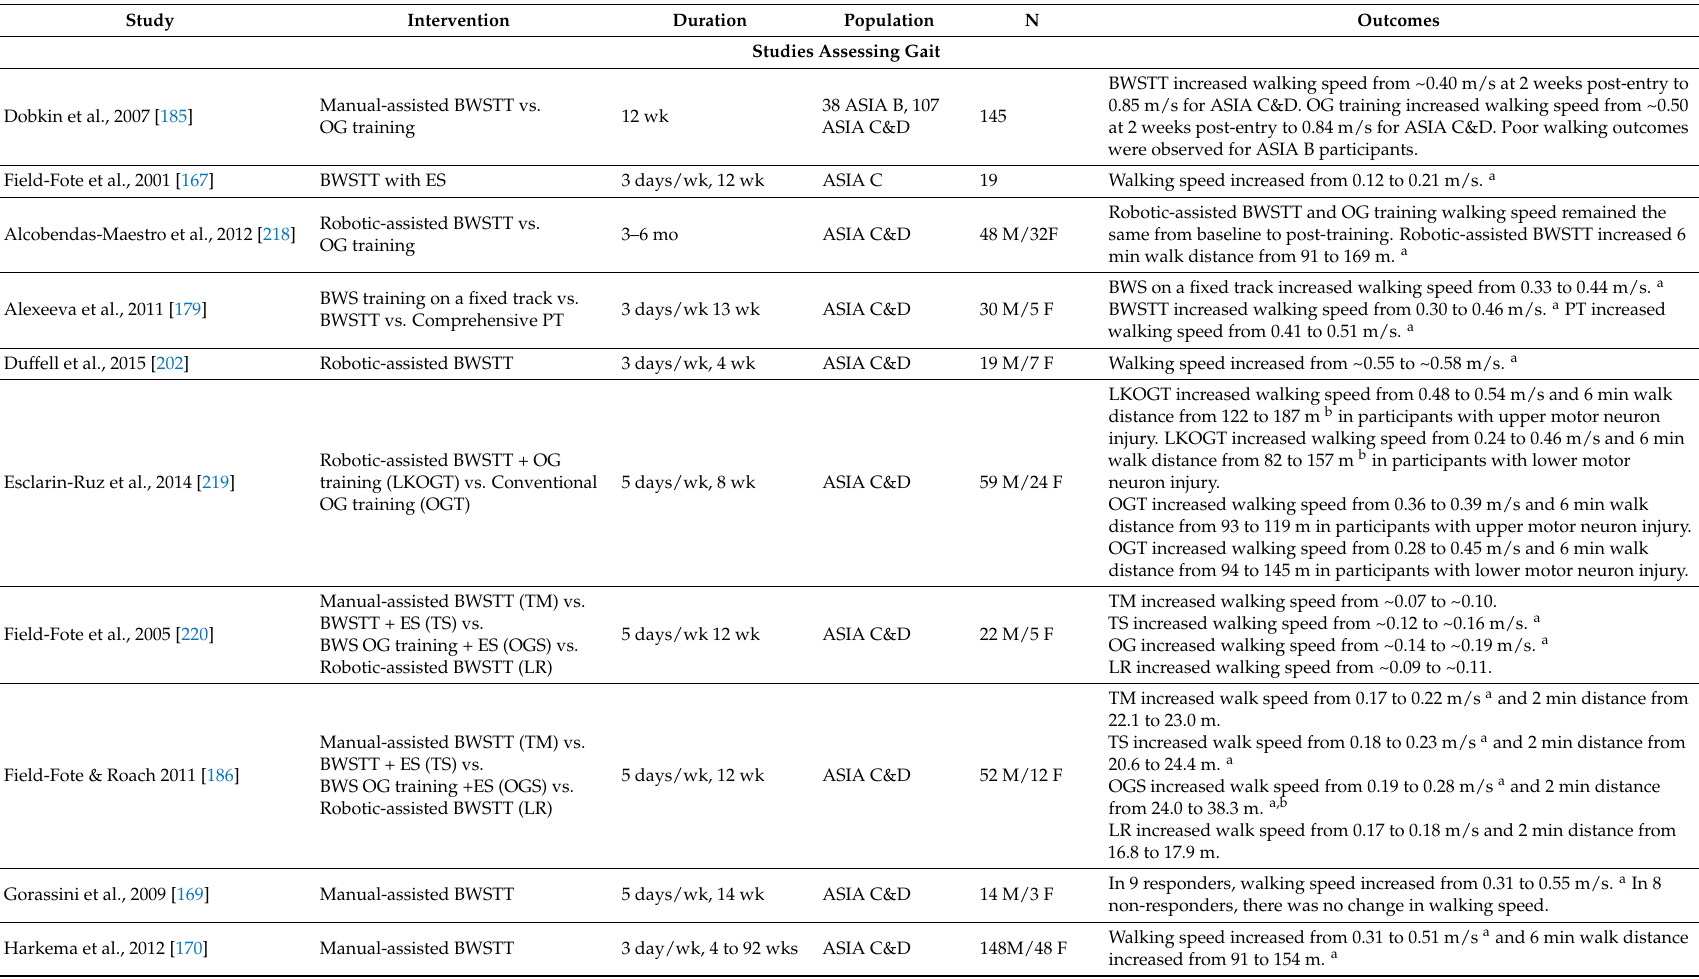
Table 1. Characteristics of Bodyweight Supported Locomotor Training in Human Spinal Cord Injury